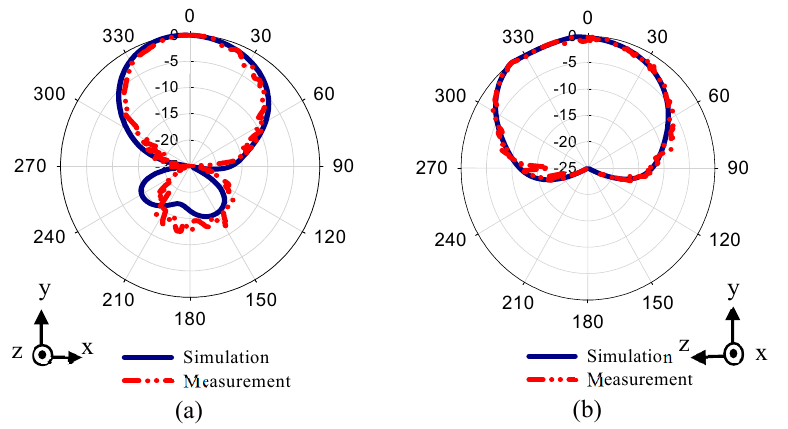
Figure 7. Normalized radiation patterns of the dipole antenna at 28 GHz: ( a ) E-plane (xy) and ( b ) H-plane (zy).